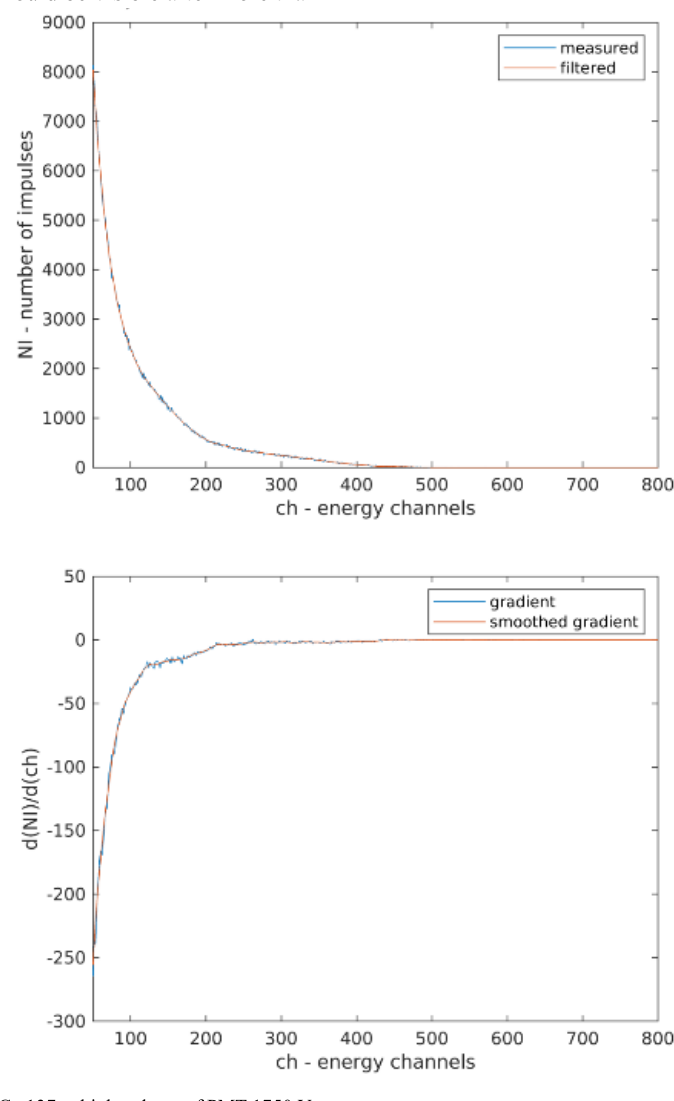
Fig. 2. Energy calibration using CE of Cs-137 at high voltage of PMT 1750